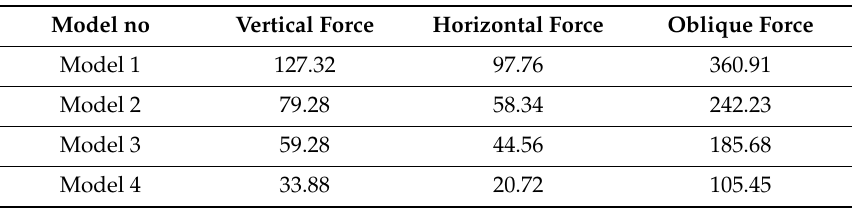
Table 2. Maximum von Mises Stress in Implants